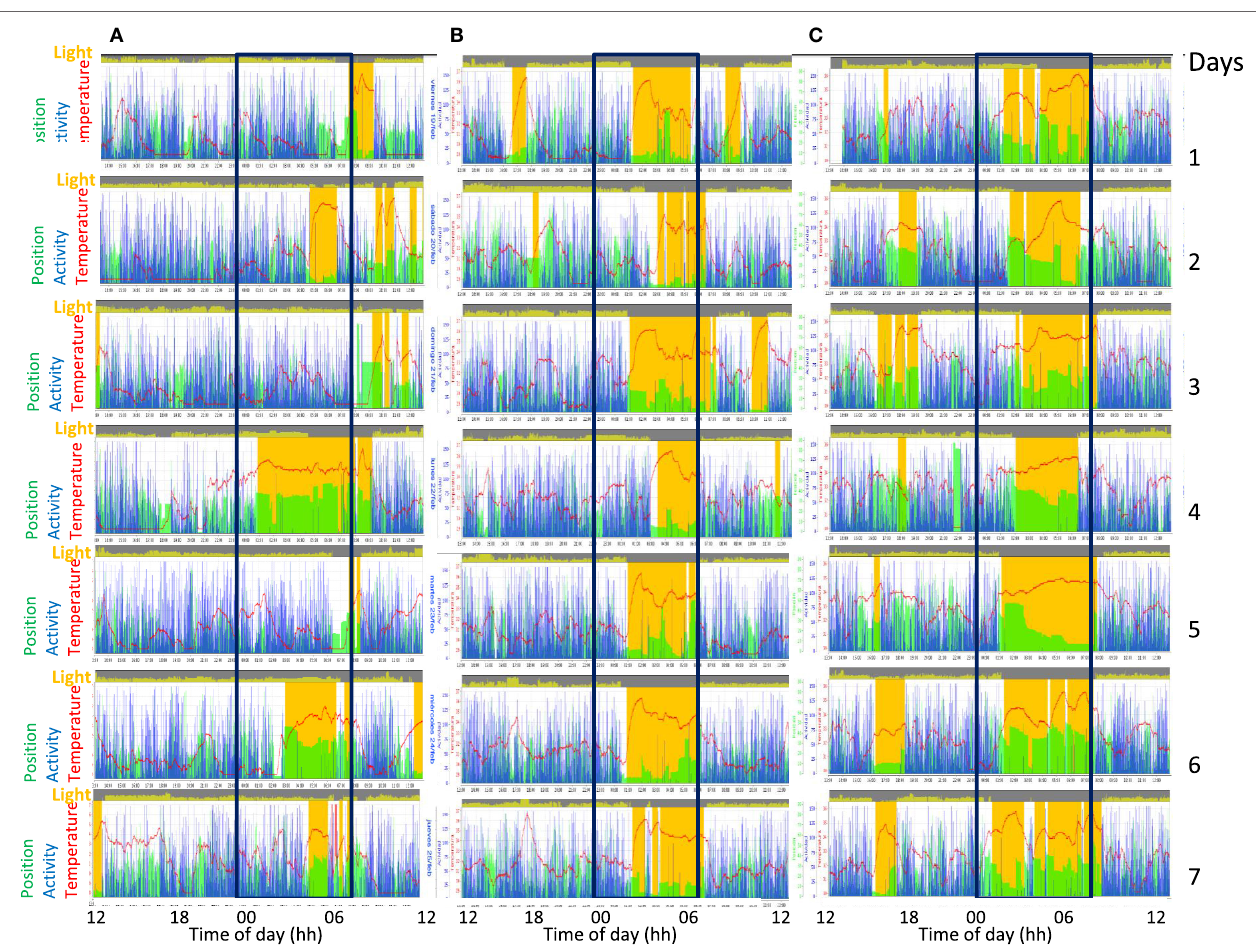
FigUre 7 | Actograms from ACM recordings of the same patient with advanced Parkinson’s disease, monitorized during 3 weeks: before (a) , 1 week (B) , and 6 months (c) after levodopa-carbidopa intestinal gel (LCIG), treatment. Each recorded day is represented sequentially in the same row. Sleep is shown in orange bars, motor activity in blue, wrist position (X tilt) in green, skin temperature as a red line, and visible light in yellow at the top of each day. Note the progressive improvement of circadian rhythmicity in response to LCIG